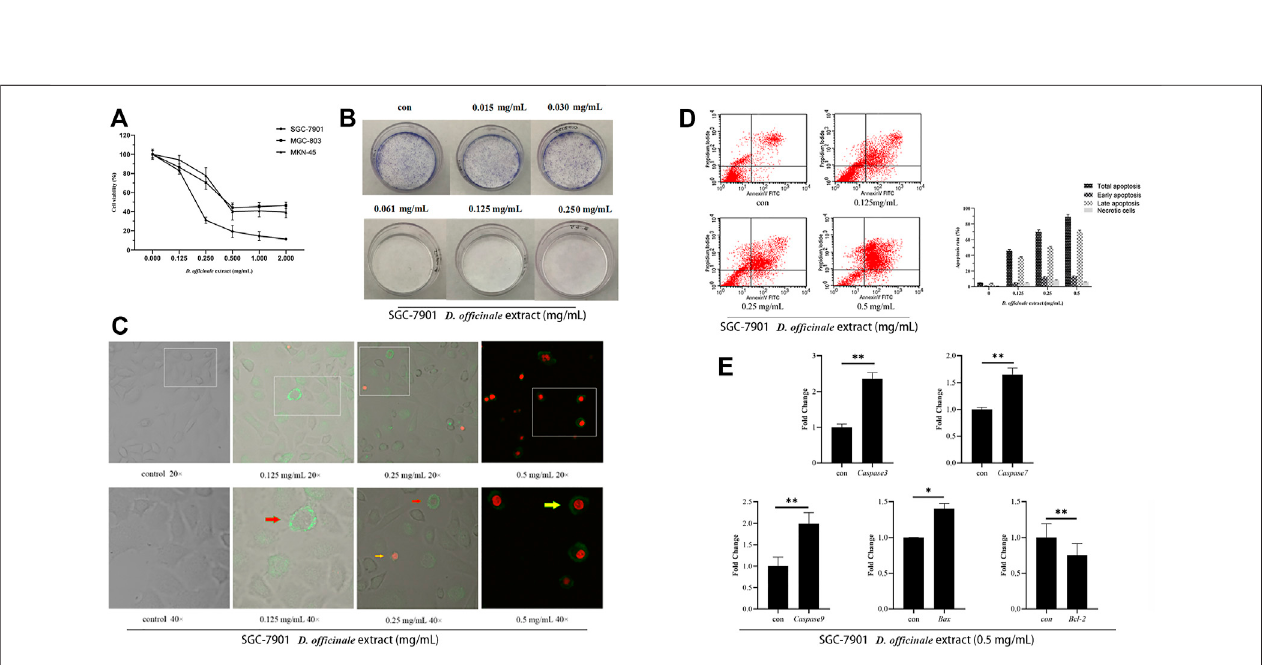
FIGURE9| D.of fi cinale extract exhibitedanti-cancer effects inSGC-7901, MGC-803,and MKN-45 cells. (A) Thecellviabilitywasassessed byMTTassayafter D. of fi cinale extract administration for 24 h. The cells were incubated with 0 – 2 mg/ml of D. of fi cinale extract. n = 3. (B) Colony formation in the presence of D. of fi cinale extract. n = 3. (C) Confocal laser analysis of GC cells treated with D. of fi cinale extract. n = 3. (D) Apoptosis analysis of D. of fi cinale extract-treated GC. n = 3. (E) Fluorescence quantitativedetection of Caspase-3 , Caspase-7 , Caspase-9 , Bax , and Bcl-2 after treating GCcells with.5 mg/ml D. of fi cinale extract for4 h* p < .05, ** p < .01 vs.